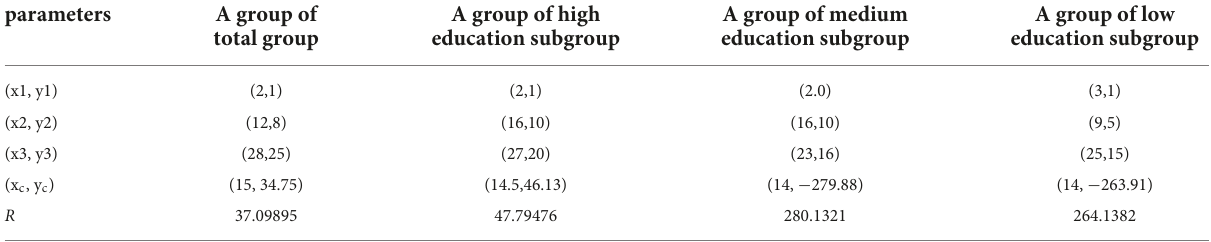
TABLE 2 Conversion parameter of circle-arc method.